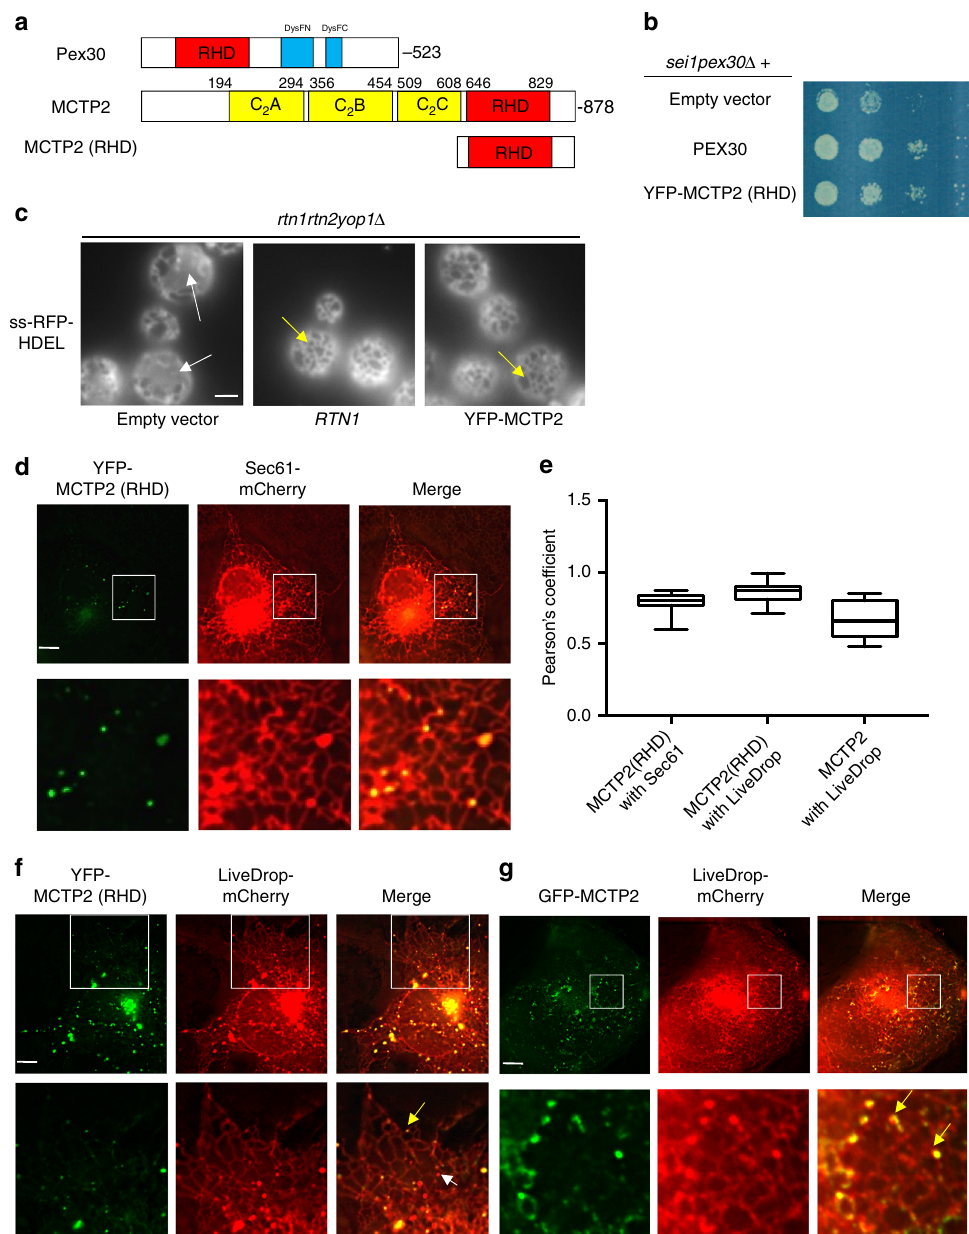
Fig. 5 Evidence that human MCTP2 is a functional homolog of Pex30. a Domains in Pex30, MCTP2, and MCTP2 (RHD). Pex30 contains a dysferlin (DysF) domain that is divided into N and C portions. b Strains were grown to mid-logarithmic growth phase, serially diluted, spotted on to SC plates and incubated at 23 °C for 3 days. c Images of the rtn1rtn2yop1 Δ cells expressing the ER marker ss-RFP-HDEL and Rtn1or YFP-MCTP2 (RHD). Images are of the cell periphery. White arrows indicate ER sheets and yellow arrow show regions containing ER tubules. Bar = 3 μ m. d Images of COS7 cells co-transfected with plasmids expressing YFP-MCTP2 (RHD) and Sec61-mCherry. e Pearson ’ s coef fi cient of colocalization of experiments shown in d , f , and g . n = 100 cells. The box covers the 25 th to 75 th percentiles, the whiskers mark the highest and lowest values and the median is indicated. f, g Images of COS7 cells co- transfected with plasmids expressing LiveDrop-mCherry and YFP-MCTP2 (RHD) ( f ) or GFP-MCTP2 ( g ). Yellow arrow indicates co-localization and white arrow indicates a LiveDrop puncta that does not colocalize with YFP-MCTP2 (RHD) or GFP-MCTP2. In e , f , and g , stacks of 20 images with a step size of 0.3 μ m were deconvolved; images from single plane are shown. Bars = 5 μ